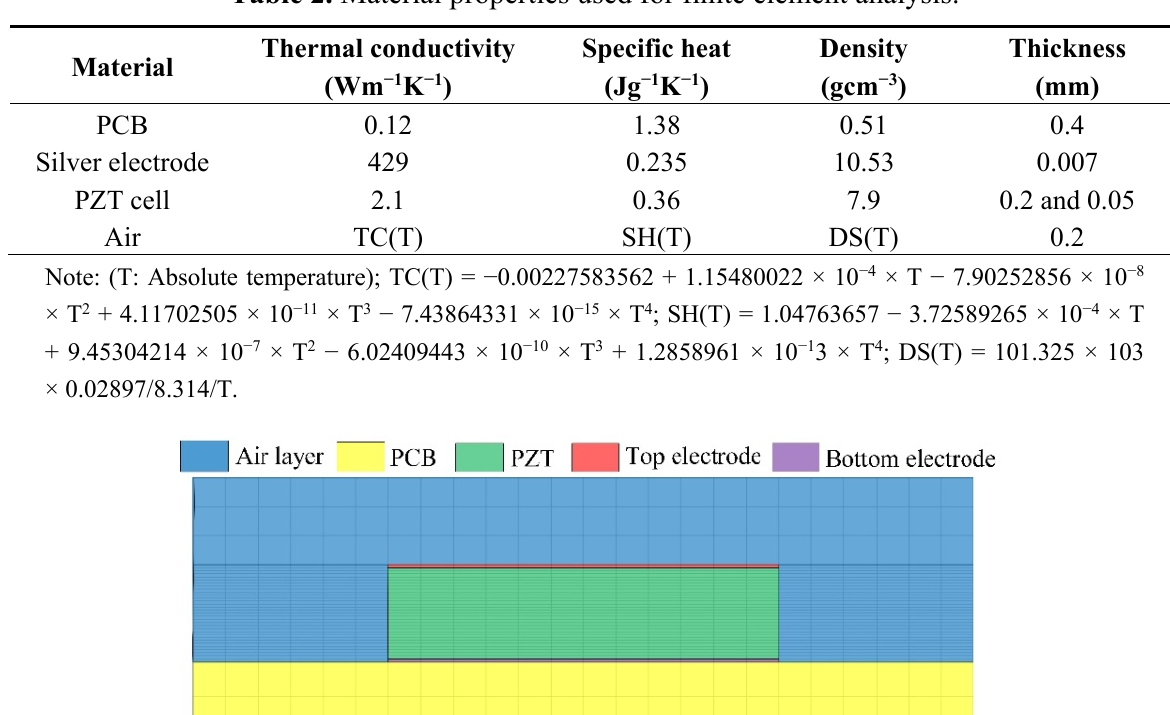
Table 2. Material properties used for finite element analysis.